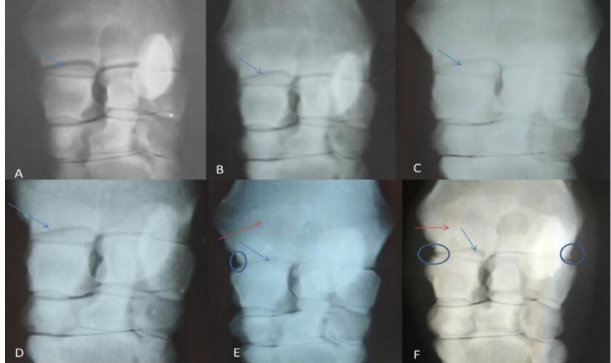
Figure 1. Showing radiographic grading: ( A ) normal (Day 0), ( B ) after one month of induction, ( C ) after 2 months, ( D )after 3 months, ( E )after 5 months, ( F ) After 7 months. The radio-carpal joint space showed gradual narrowing (blue arrows), subchondral bone sclerosis (red arrows) and osteophyte appeared in late stages